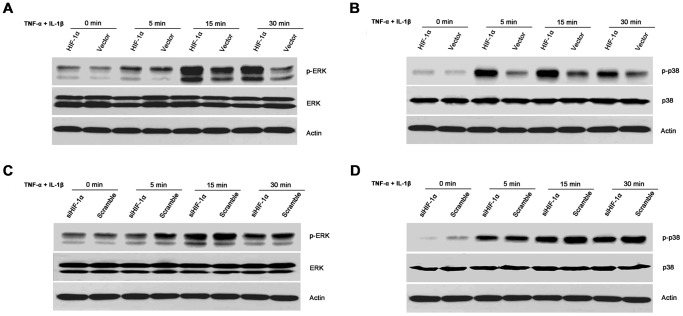
HIF-1α activated the signalling pathways controlling IL-33 expression.A-B, HIF-1α overexpression synergized with TNF-α and IL-1β to induce the activation of ERK and p38 pathways. RASF were transfected with pcDNA3.1 or pcDNA3.1-HIF-1α. 24 h later, the cells were stimulated with 10 ng/ml TNF-α plus 2 ng/ml IL-1β for 5 min, 15 min, and 30 min, respectively. Then the cells were lysised for assessment of the phosphorylation of ERK (A) and p38 (B) by Western blot. C-D, Silencing HIF-1α dampened TNF-α- plus IL-1β-induced ERK and p38 signalling pathway activation. RASF were transfected with HIF-1α siRNA or the control scramble siRNA for 24 h. Then the cells were stimulated with 10 ng/ml TNF-α plus 2 ng/ml IL-1β for 5 min, 15 min, and 30 min, respectively. After that, the cells were harvested for assaying the activation of the ERK (C) and p38 (D) pathways by Western blot. The results were representative of three independent experiments.